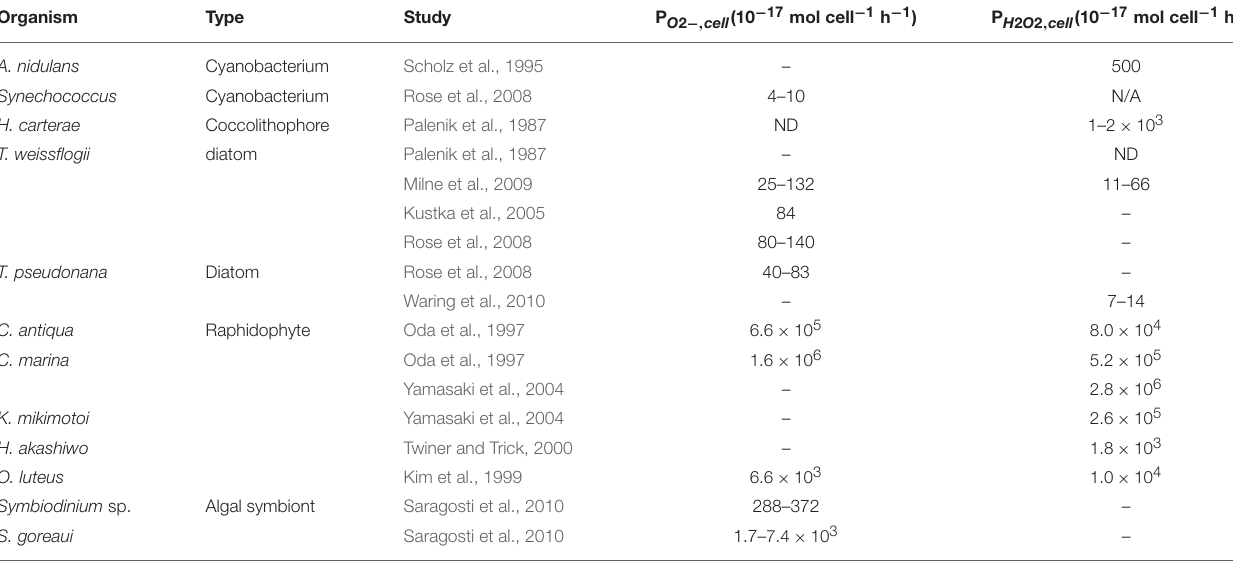
TABLE 1 | Previously published phytoplankton studies showing cell-normalized production of superoxide (P O 2 − , cell ) and hydrogen peroxide (P H 22 , cell ).